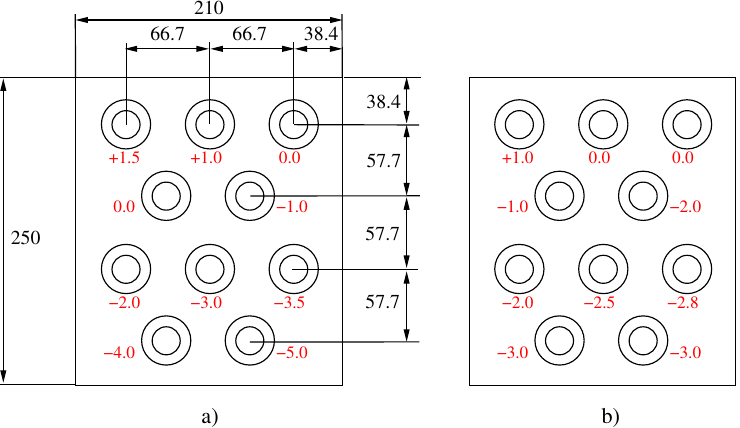
Figure 7. Layout of coupons designed for evaluating parallelism deviation (in red color close to each hole) ( a ) Mockup 1 (100 ◦ C preheating); ( b ) Mockup 2 (200 ◦ C preheating). (All measurements are in